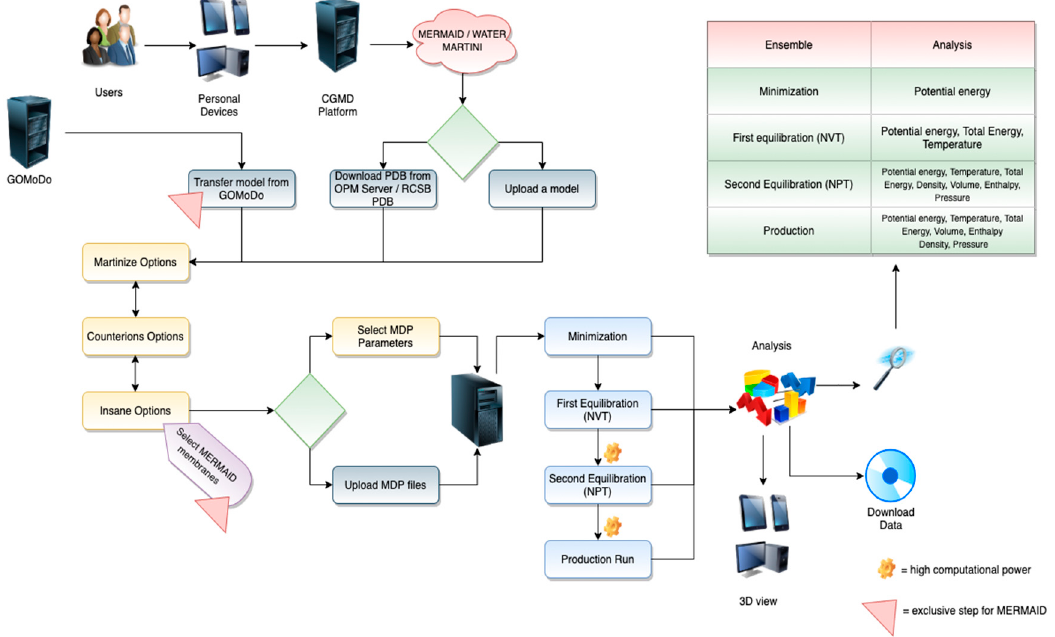
Figure 1. The Martini CoarsE-gRained MembrAne proteIn Dynamics (MERMAID) and Water Martini workflow.